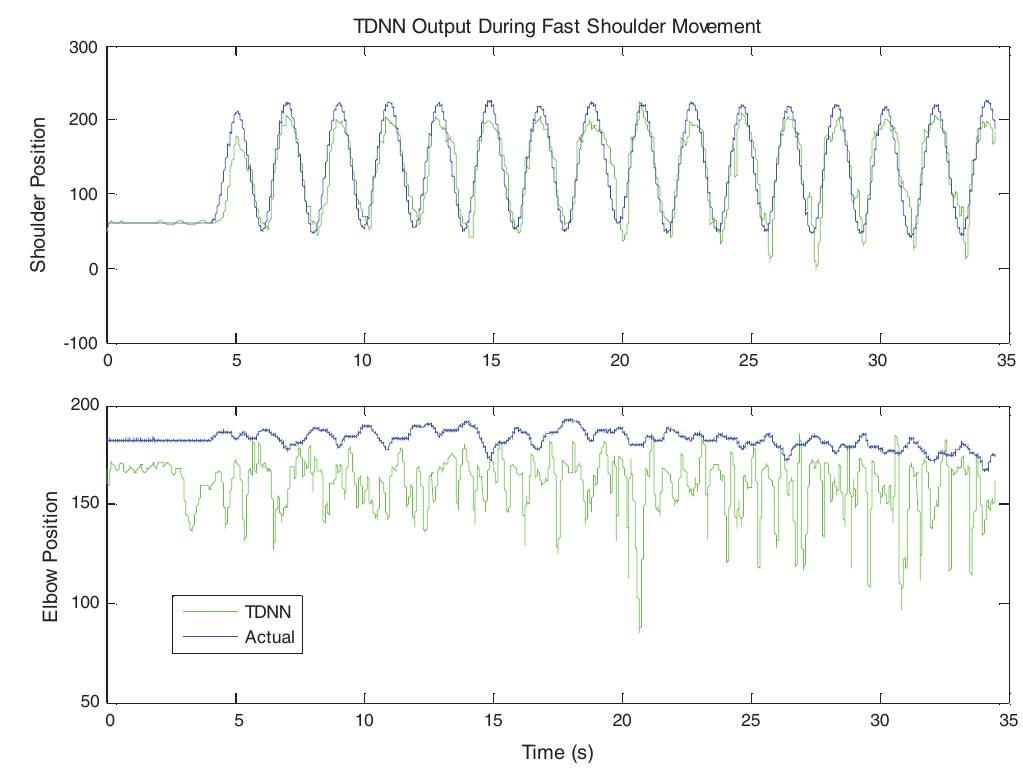
Fig. 11. The output of the TDNN during fast shoulder movement for Subject